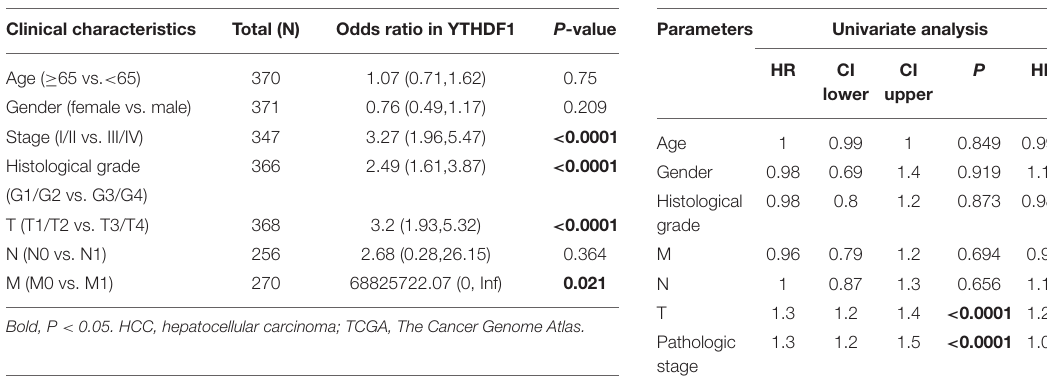
TABLE 3 | Univariate analysis and multivariate analysis of overall survival in HCC patients from TCGA. Parameters